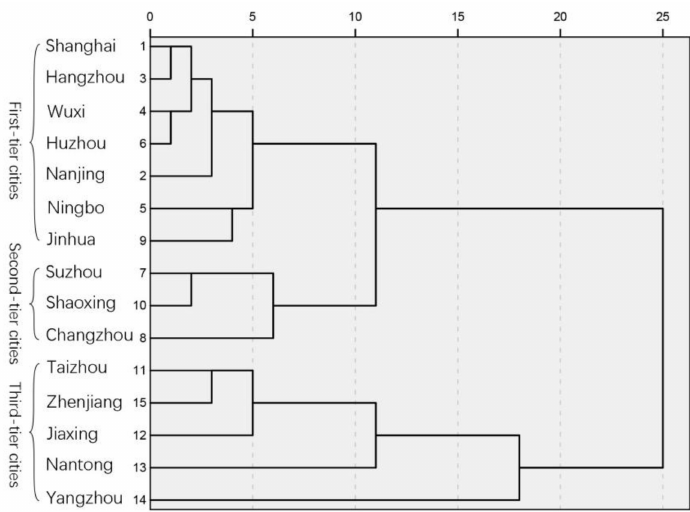
Figure 9. Cluster analysis of the dimension of ‘Intelligent Economy and Industry’.